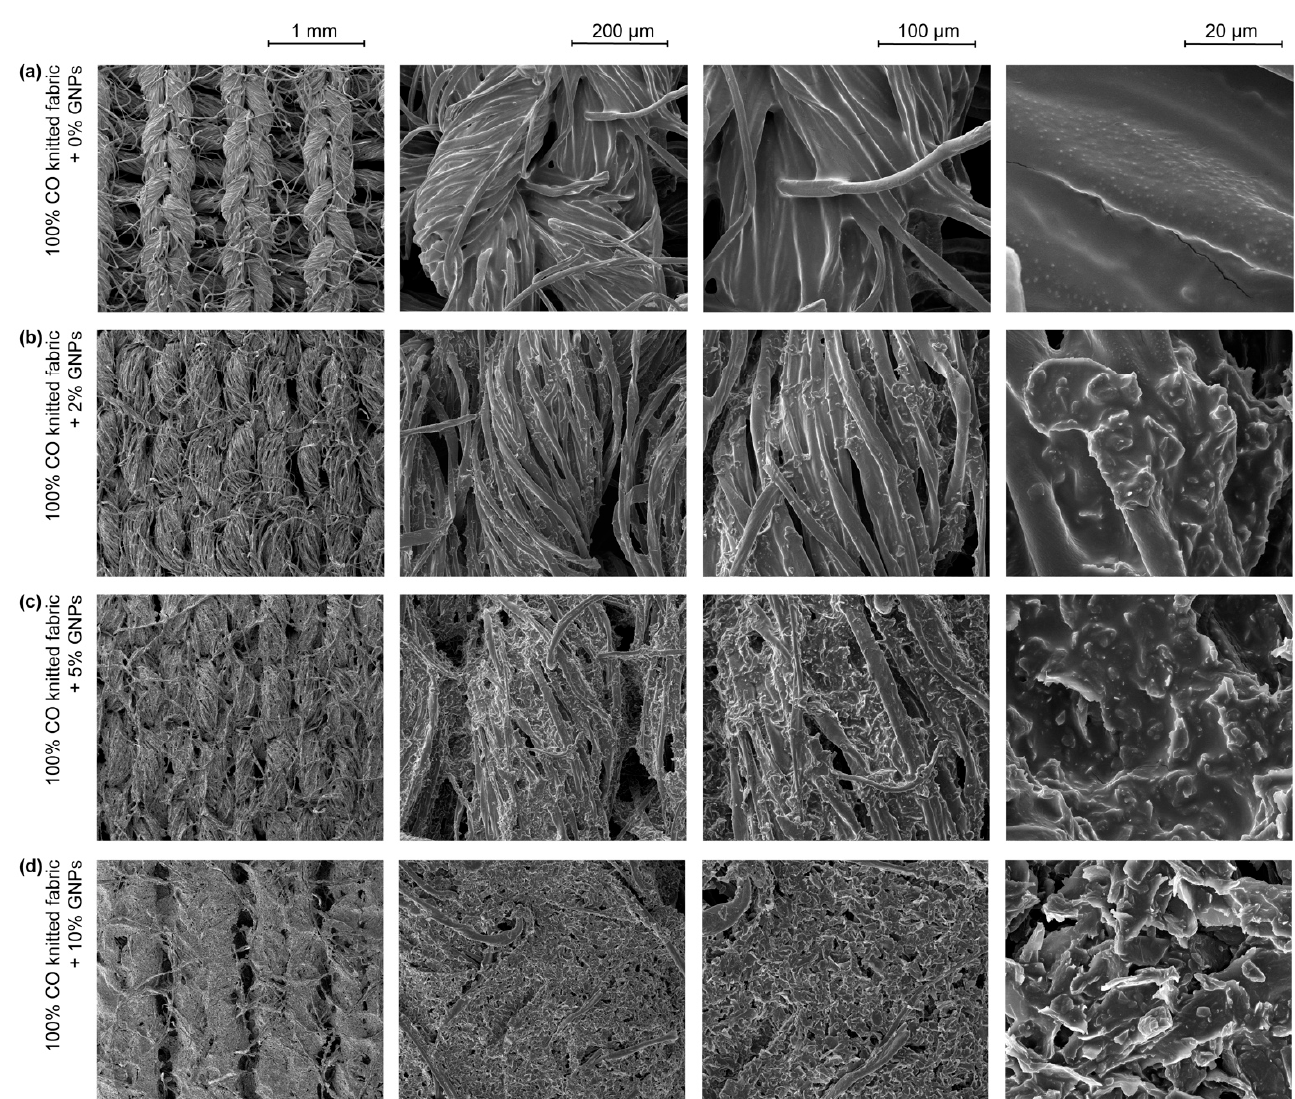
Figure 6. FESEM images of 100% CO knitted fabric: ( a ) 0% GNPs; ( b ) +2% GNPs; ( c ) +5% GNPs; ( d ) +10% GNPs.